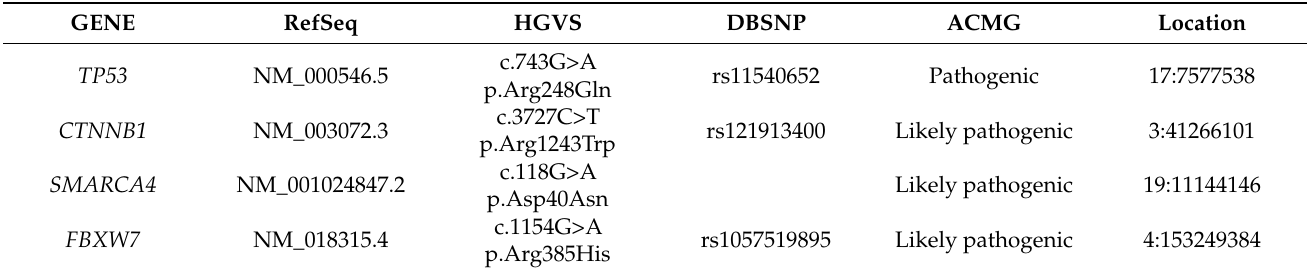
Figure 4. Single nucleotide polymorphism (SNP) array image by Bluefuse Multi Software: each chromosome, whose number is reported on the X axis, is represented as a grey or white area. Duplications/deletions are showed as an upward/downward shift of baseline (log R ratio = 0 for autosomal chromosomes). Low-level mosaicism (<20%) cannot be detected by this technique. Table 1. Prediction analysis and American College of Medical Genetics (ACMG) classification of somatic variants observed with next-generation sequencing (NGS) analysis of tumor tissue.